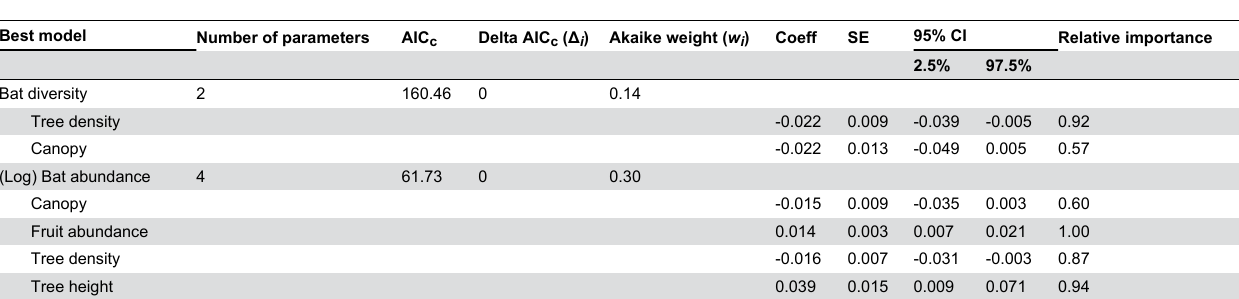
Table 5. Best model selections using Akaike information criterion (AICc) approach and model averaging with bat diversity and (log) bat abundance as dependent variables and tree density, tree height, canopy and fruit abundance as independent variables.